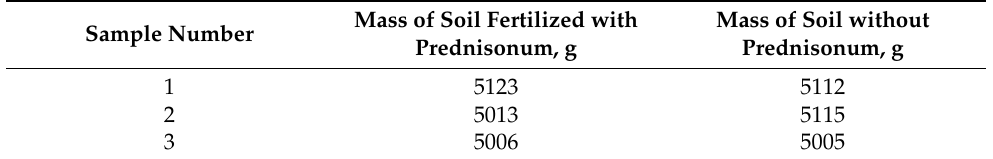
Table 4. Physical characteristics of prepared samples.